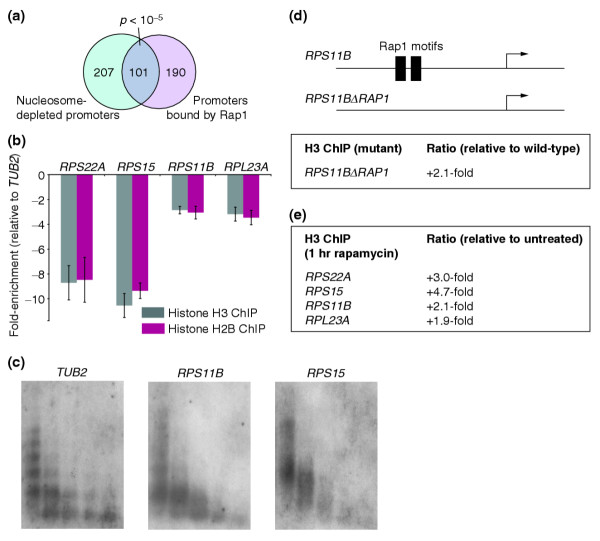
Nucleosome depletion in the vicinity of Rap1-binding sites. (a) Overlap between the 308 most nucleosome-depleted promoters and promoters found to recruit Rap1 in a global ChIP study [1]. (b) Nucleosome depletion in the vicinity of Rap1-binding sites in ribosomal gene promoters evaluated by ChIP. Fold-enrichment was determined by real-time PCR using primers that span Rap1-binding motifs in the RPS22A, RPS15, RPS11B and RPL23A promoters. (c) Southern blots showing DNA from yeast spheroplasts digested with increasing concentrations of micrococcal nuclease probed with labeled PCR products spanning the TUB2 promoter and the Rap1 sites in the RPS11B and RPS15 promoters. (d) Nucleosome occupancy for a mutant RPS11B promoter lacking Rap1 consensus sites was determined by H3 ChIP and real-time PCR. The mutant promoter is enriched 2.1-fold relative to wild type. (e) Nucleosome occupancy at Rap1-binding sites in ribosomal protein gene promoters after treatment with rapamycin evaluated by H3 ChIP and real-time PCR.